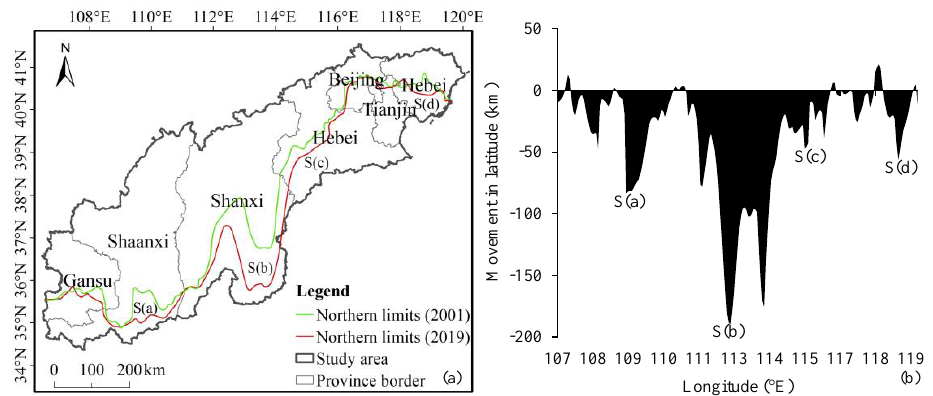
Figure 8. ( a ) Derived extent of the northern limit of winter wheat (NLWW) and ( b ) latitudinal movement of the NLWW during the period 2001–2019. (Red solid line represents the NLWW in 2019, green solid line represents the NLWW in 2001, black bars indicate latitudinal movement of the NLWW, and S(a, b, c, d) represent typical points of southward migration.). In the past 20 years, the shift of the NLWW has exhibited a marked fluctuating trend of southward movement. During this migration, the amplitude of the shift reflected in each period has varied. The period with the most substantial southward movement was 2007–2014.